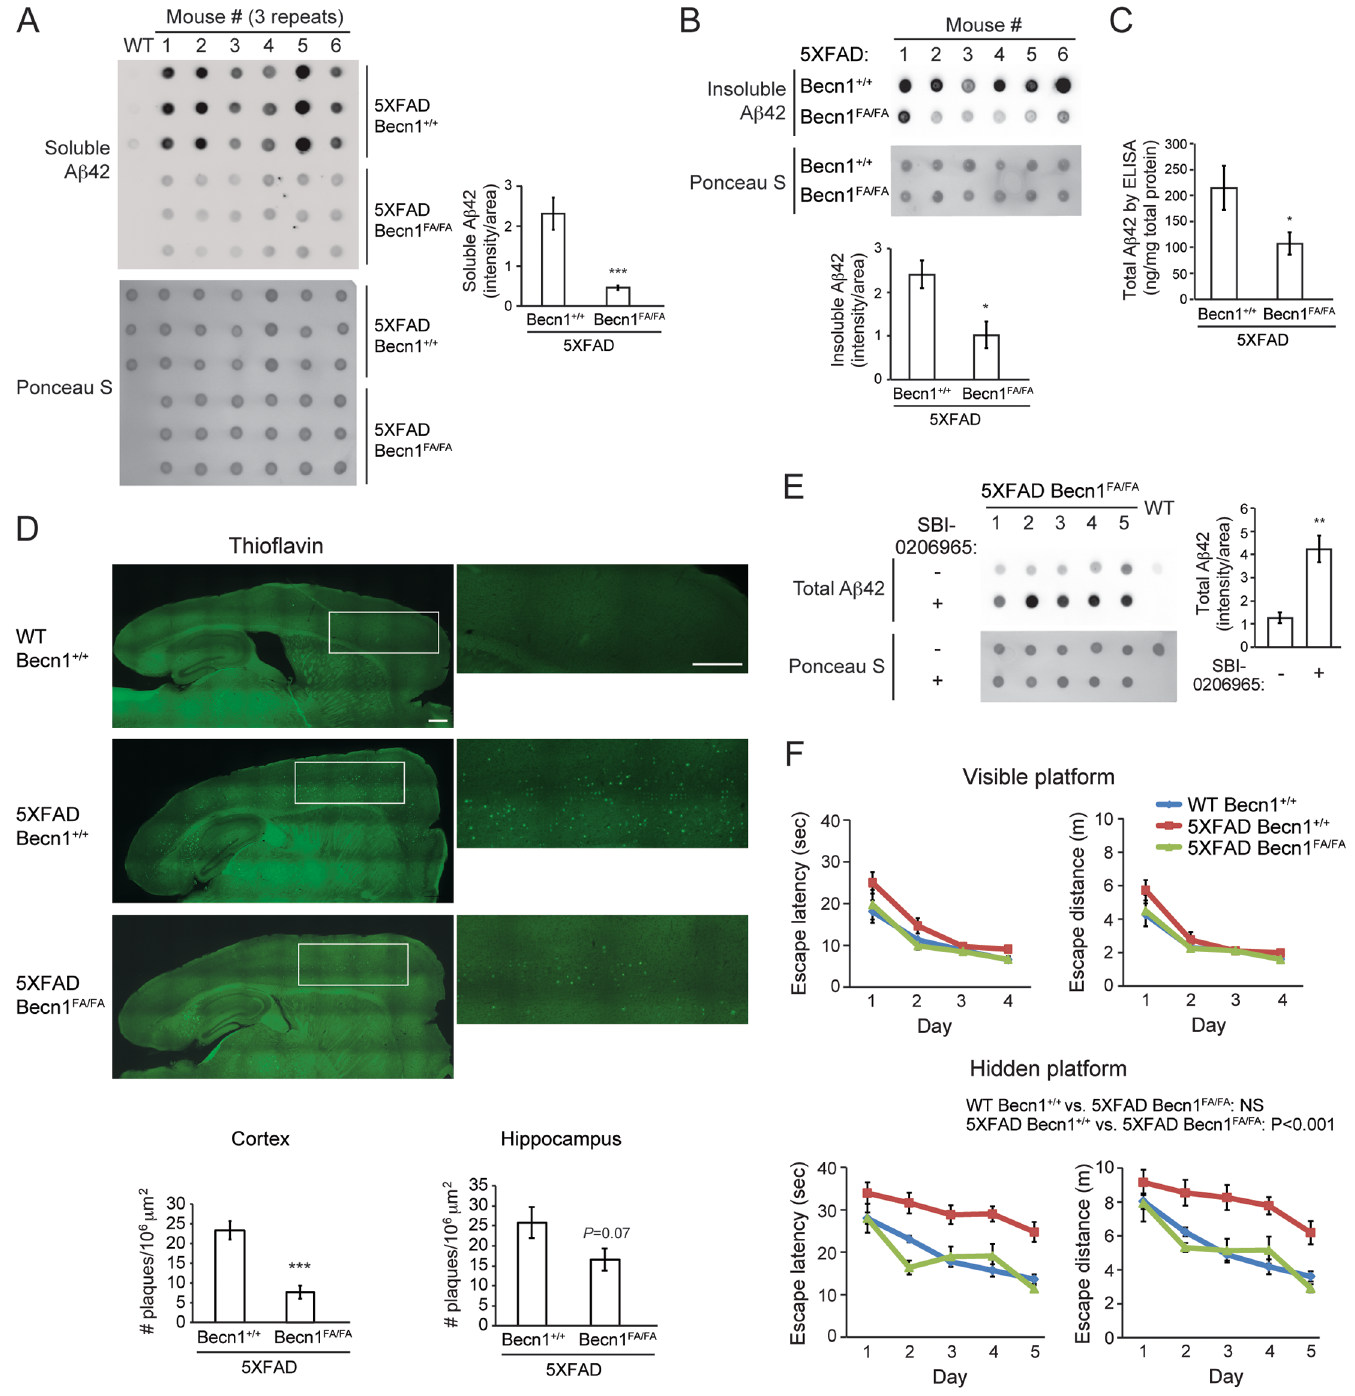
Fig 3. Becn1 FA/FA mutation ameliorates cerebral A β accumulation, memory deficits and mortality of Alzheimer’s mouse models. (A-B) Dot-blot assays and quantification of soluble (A) and insoluble (B) A β 42 levels in homogenated brain samples of 6-month old 5XFAD Becn1 +/+ and 5XFAD Becn1 FA/ FA mice, immunostained with anti-A β 42antibody.Total protein loadingwas labeledby Ponceau S. Triplicate experiments from 6 mice in each group were shown. *** , P < 0.001,t test. (C) ELISA analysesof total (solubleand insoluble)A β 42 levels in the cortex of 6-month old 5XFAD Becn1 +/+ and 5XFAD Becn1 FA/FA mice. N = 7. (D) Representative images (upper) and quantification (lower) of amyloidplaquesstained by Thioflavin S in brain (cortex and hippocampus) of 5XFAD Becn1 +/+ and 5XFAD Becn1 FA/FA mice. Magnification of the enclosedregionsis shown on the right. N = 6–8. Scale bar: 500 μ m. *** , P < 0.001,t test. (E) Dot-blot assays and quantificationof total A β 42 levels in homogenated brain samplesof 6-month old 5XFAD Becn1 FA/FA mice treated with the autophagyinhibitor SBI-0206965 or vehicleonce per day for 7 days. Total protein loadingwas labeledby PonceauS. N = 5. ** , P < 0.01,t